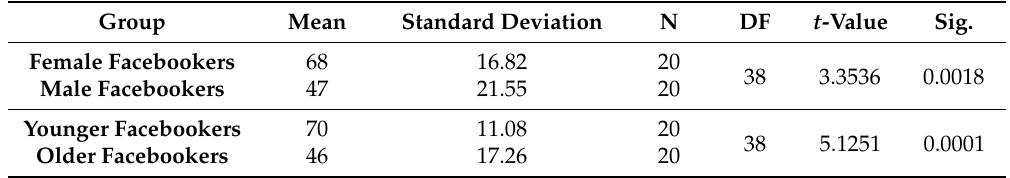
Table 3. The results of the t -test of differences between the groups in terms of gender and age. Group Mean Standard Deviation N DF t -Value Sig. Female Facebookers 68 16.82 20 38 3.3536